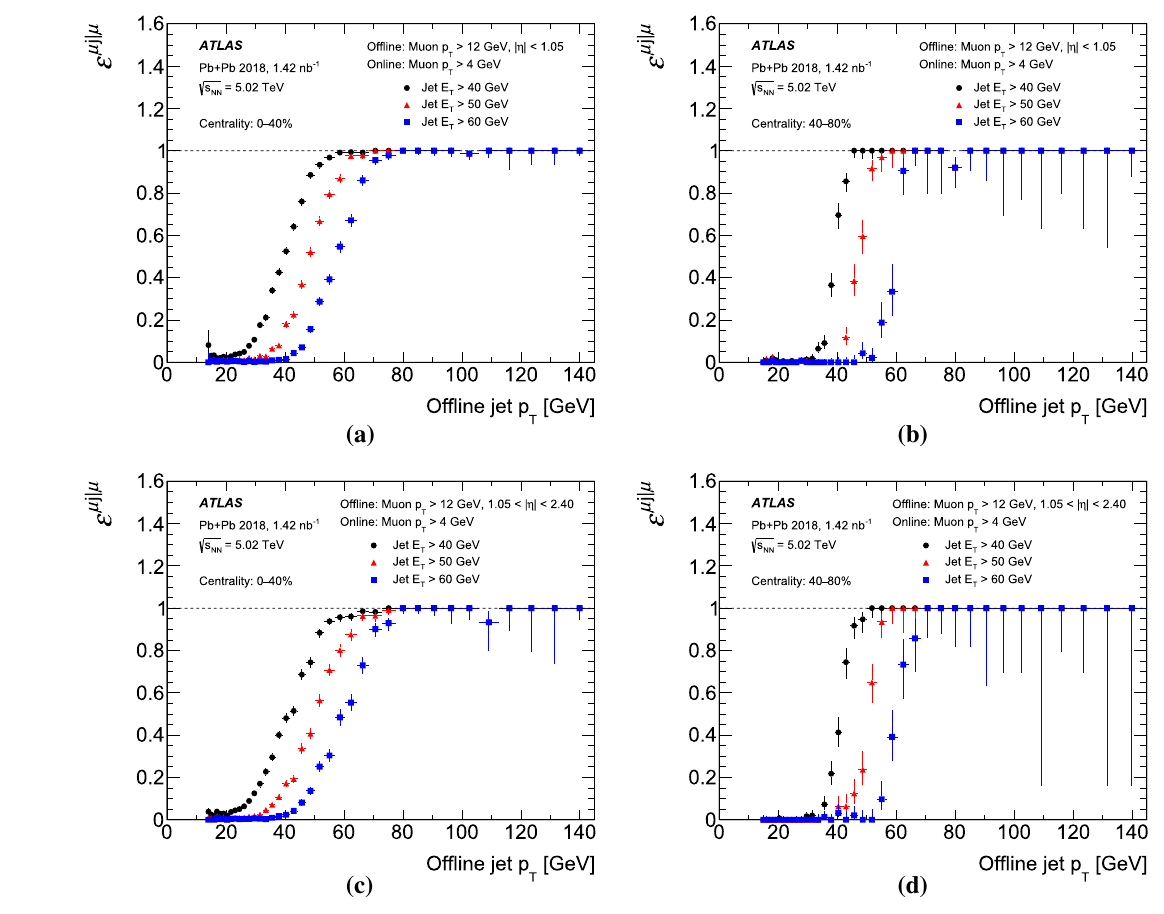
Fig. 16 The conditional muon-jet trigger efficiency, ε μ j | μ , as defined in Eq. (1), as a function of offline jet p T . The muon-jet triggers shown require a muon with p T > 4GeV and jet E T thresholds of 40, 50, and 60GeV. The muon-jet trigger efficiency is estimated relative to the single-muontriggerrequiringamuonwith p T > 4GeV.Eventsarealso